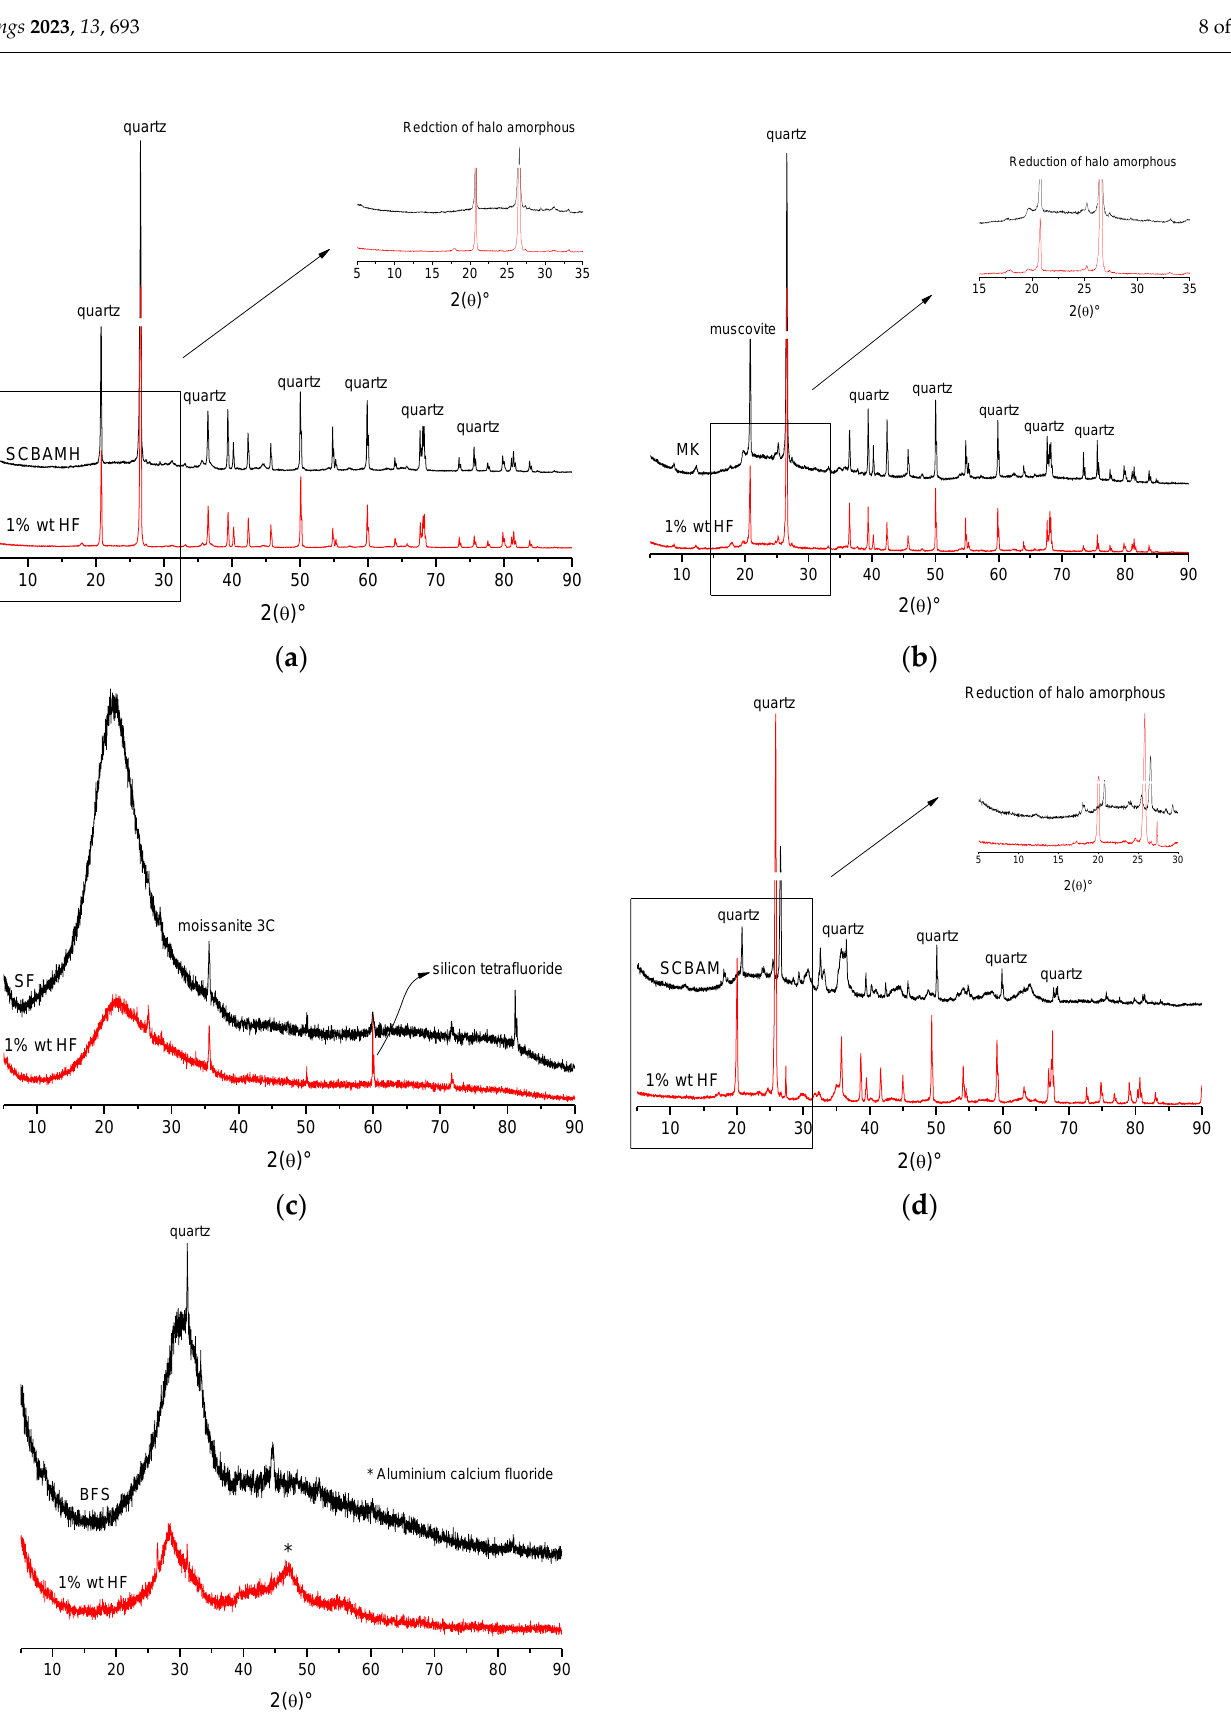
Figure 3. XRD test ( a ) SCBAMH, ( b ) MK, ( c ) SF, ( d ) SCBAM, and ( e ) BFS.